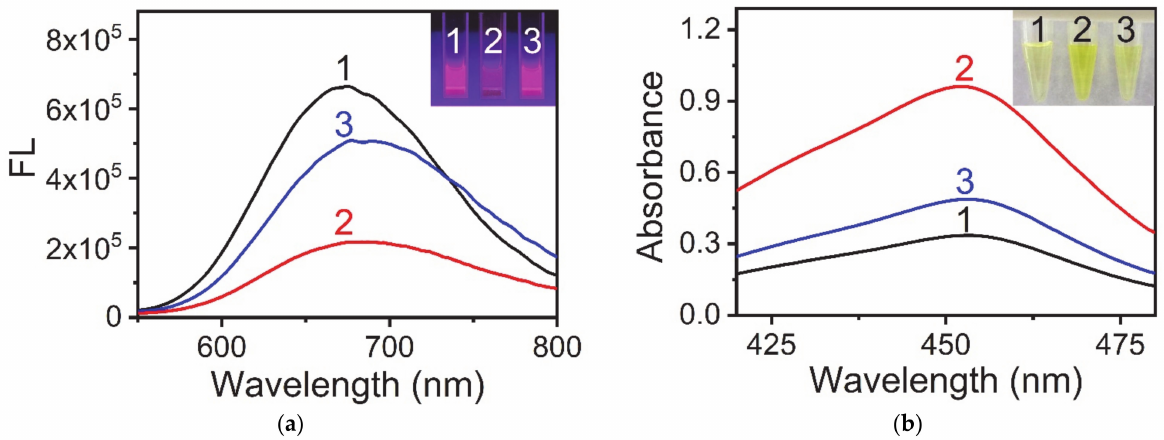
Figure 1. Interaction between AuNCs, Cu 2+ ions and PPi. ( a ) Fluorescence emission spectra and photographs of samples under UV light (inset) in different reaction systems. (1) AuNCs, (2) AuNCs and Cu 2+ ions, and (3) AuNCs, Cu 2+ ions, and PPi. ( b ) UV-vis absorption spectra and photographs of samples under visible light (inset) in different reaction systems. (1) AuNCs, TMB, and H 2 O 2 ; (2) AuNCs, Cu 2+ ions, TMB, and H 2 O 2 ; (3) AuNCs, Cu 2+ ions, PPi, TMB, and H 2 O 2 . Reaction conditions: ( a ) AuNCs, 0.25 mg · mL − 1 ; Cu 2+ , 10 µ M; PPi, 100 µ M; and BR buffer (pH 4.0); ( b ) AuNCs, 0.25 mg · mL − 1 ; Cu 2+ ,